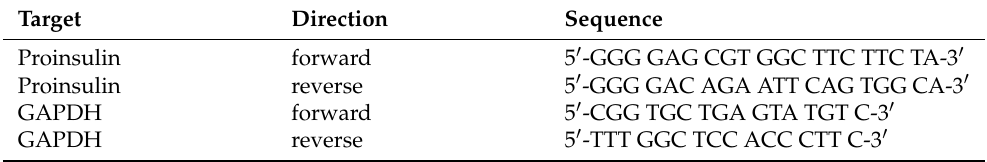
Table 1. Primer pairs applied in